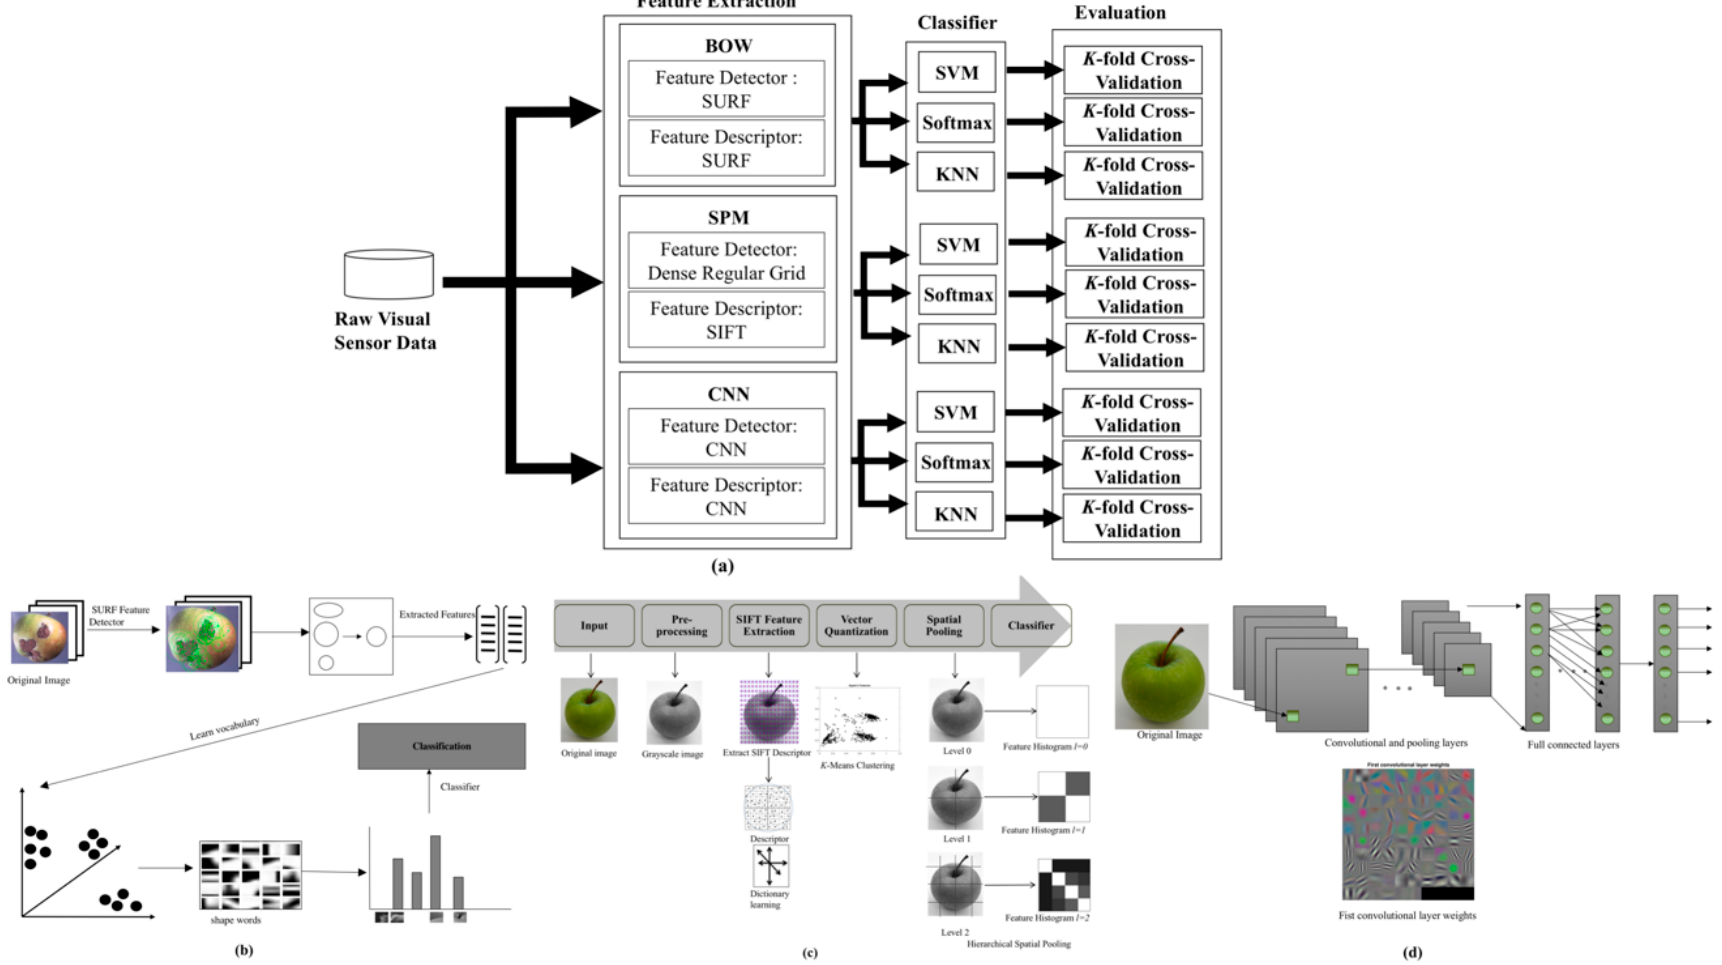
Figure 2. Vision-based apple classification ( a ) Overall scheme with three different image recognition methods ( b ) BOW, ( c ) SPM and ( d ) CNN.